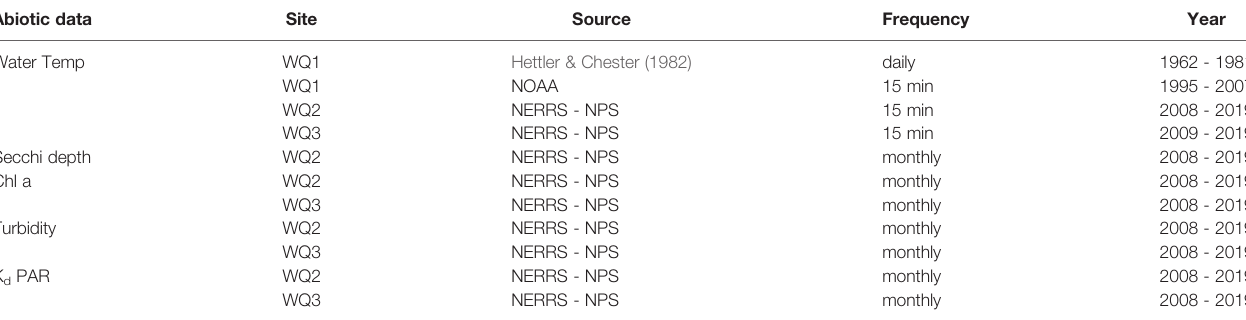
TABLE 2 | Data sources, frequency of sampling, and years of collection for all water quality measurements at each